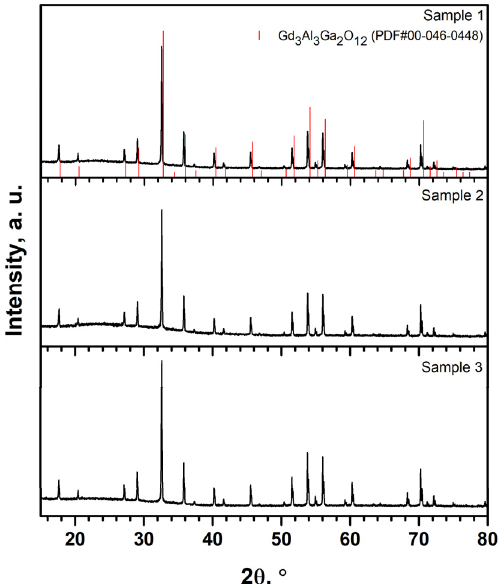
Figure 1. XRD patterns of the GAGG:Ce,Cr,Mg,Ca micropowder samples.